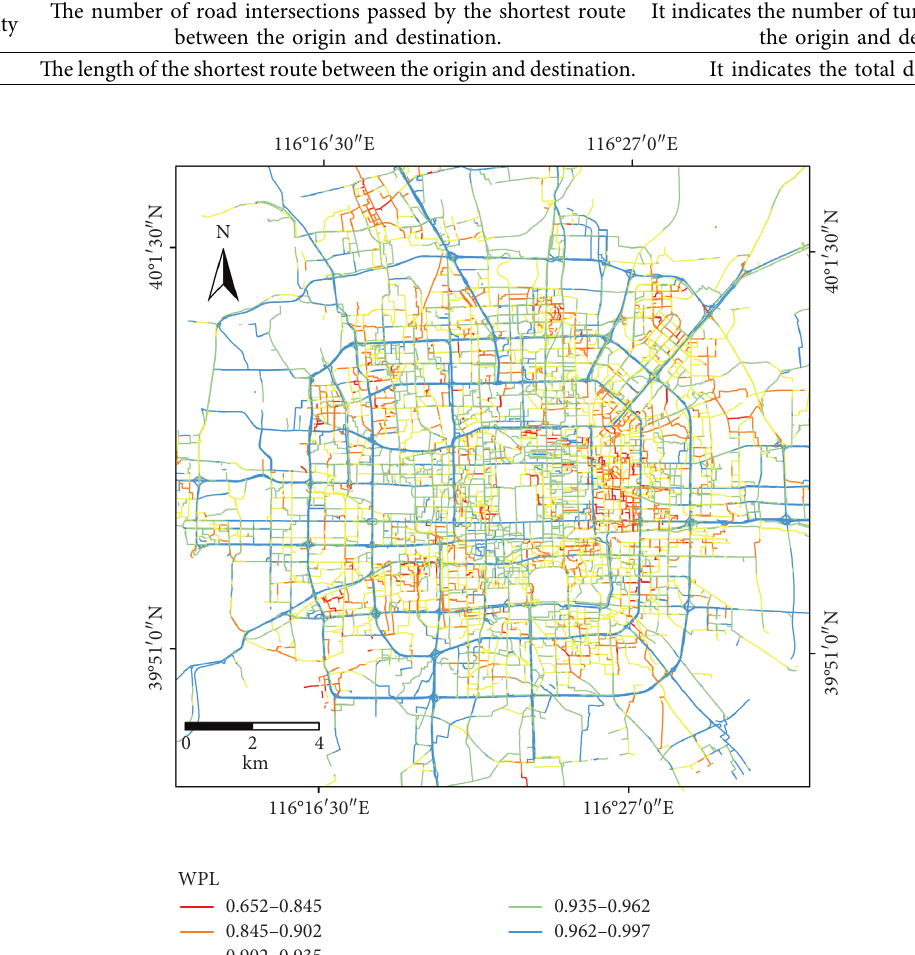
Figure 5: Spatial distribution of taxi drivers’ local wayfinding performance levels.